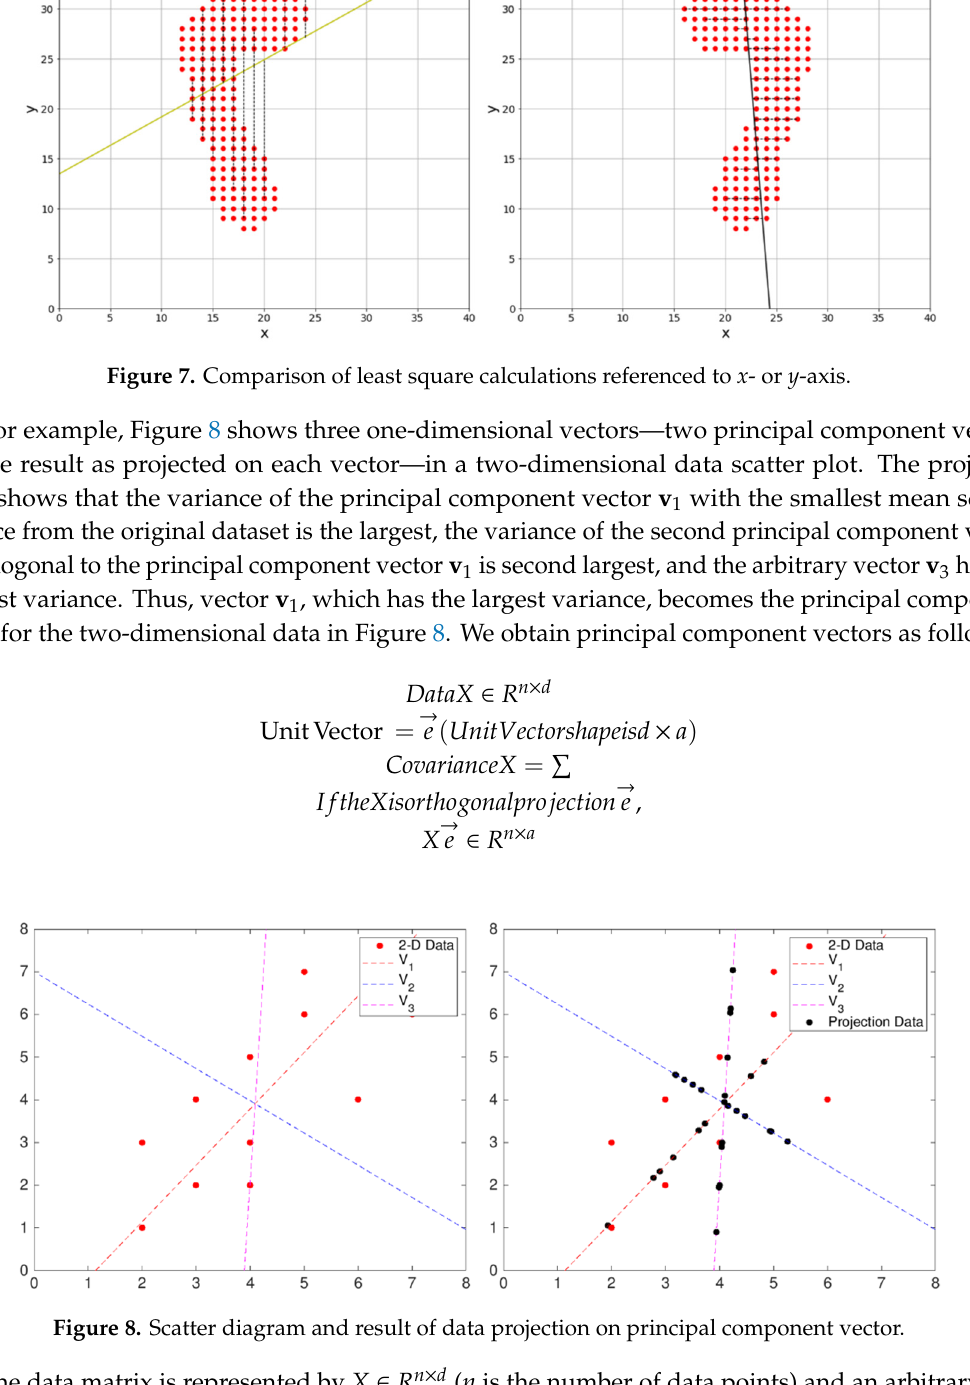
9 of 24 Figure 6. Angular measurement based on centers of gravity.